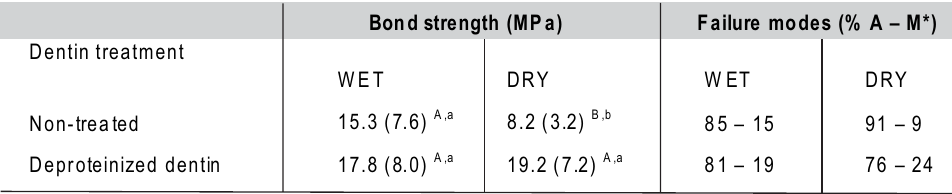
Table 1. Means (standard deviations) for microtensile bond strength and failure mode distribution.